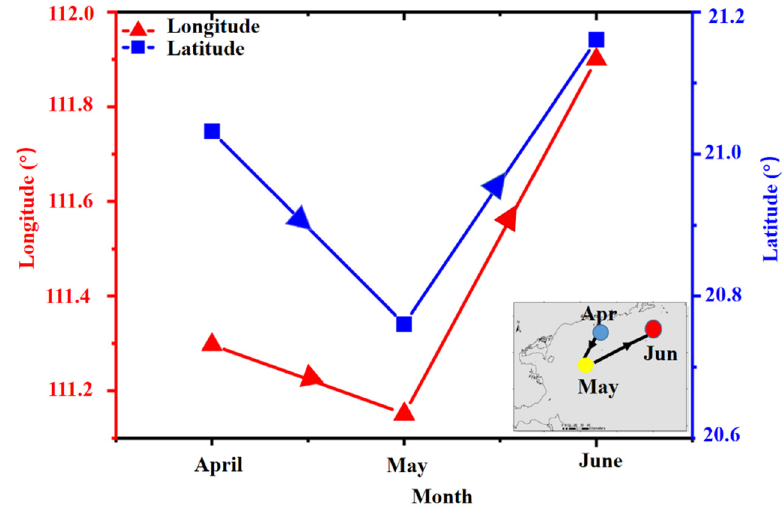
Figure 5. Variation of center of gravity (CoG) of fish larvae density in the WGWs.